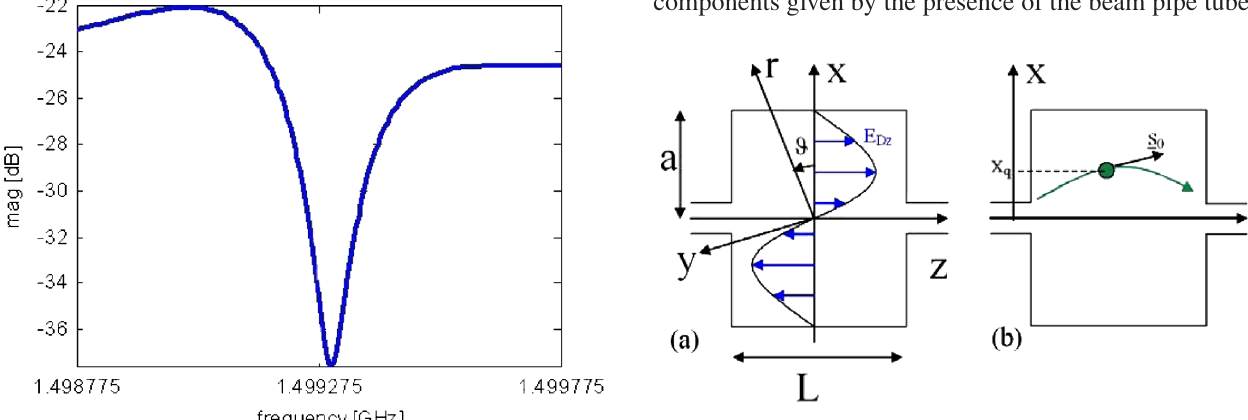
FIG. 11. (Color) (a) Sketch of a RFD cavity with the E Dz field (blue vectors). (b) Sketch of a particle passing through the RFD on the deflection plane ð x; z Þ .